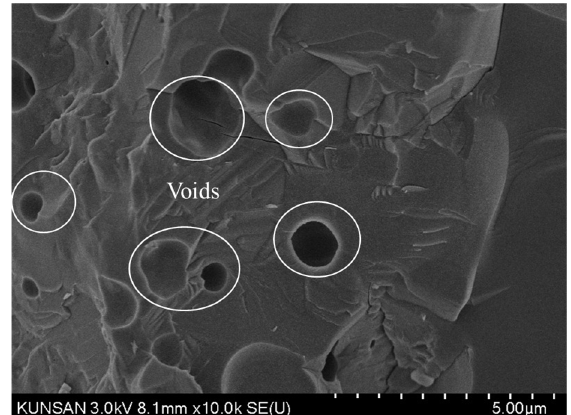
Figure 2. Grading curve of CBA and crushed fine aggregates.